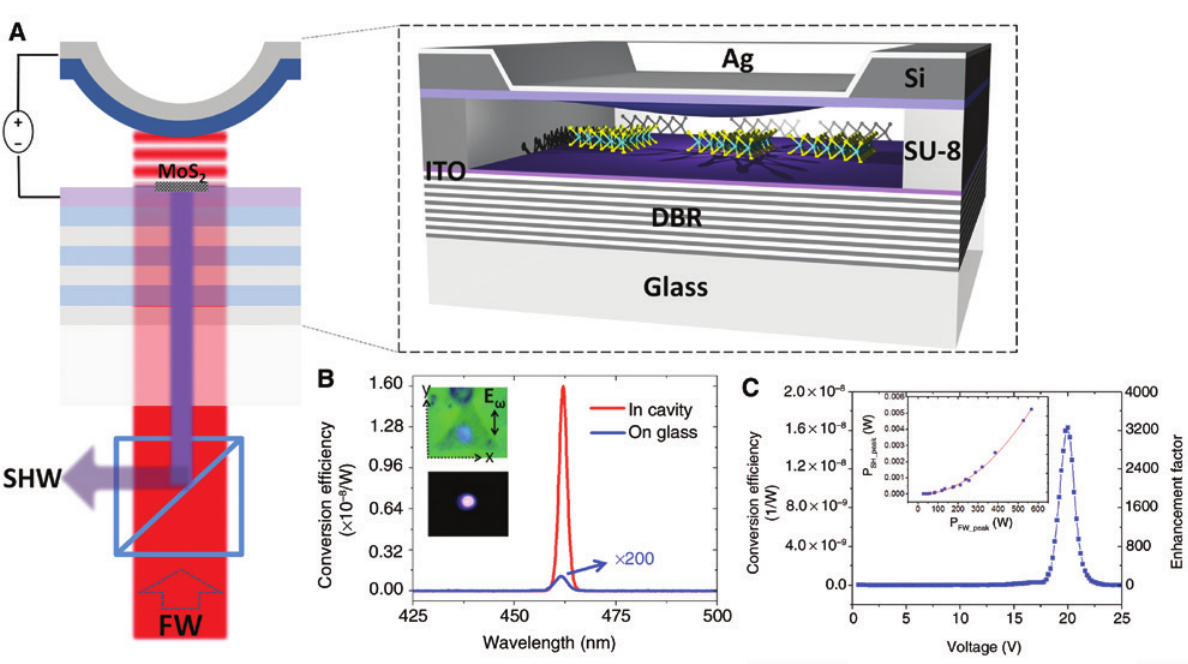
Figure 4: Second harmonic generation in double-mode